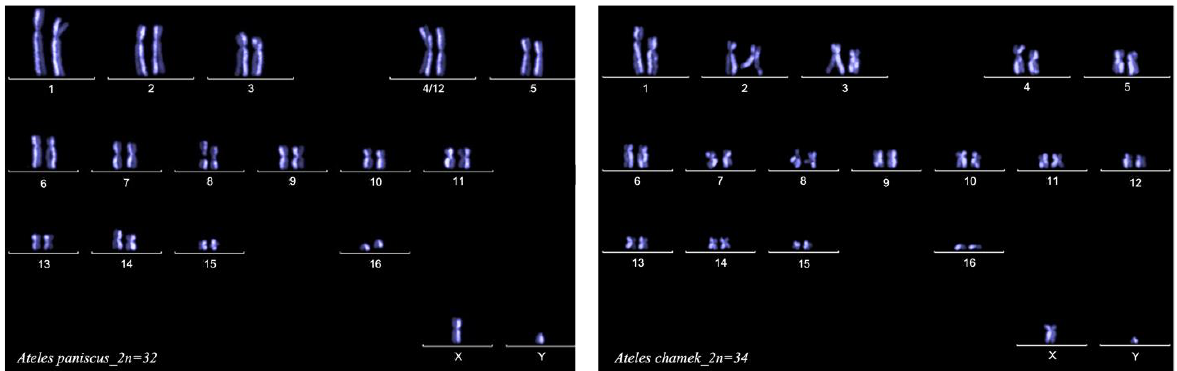
Figure 2 . Harlequin staining pattern of chromosomes arranged in the typical karyotypes for A. paniscus and A. chamek .